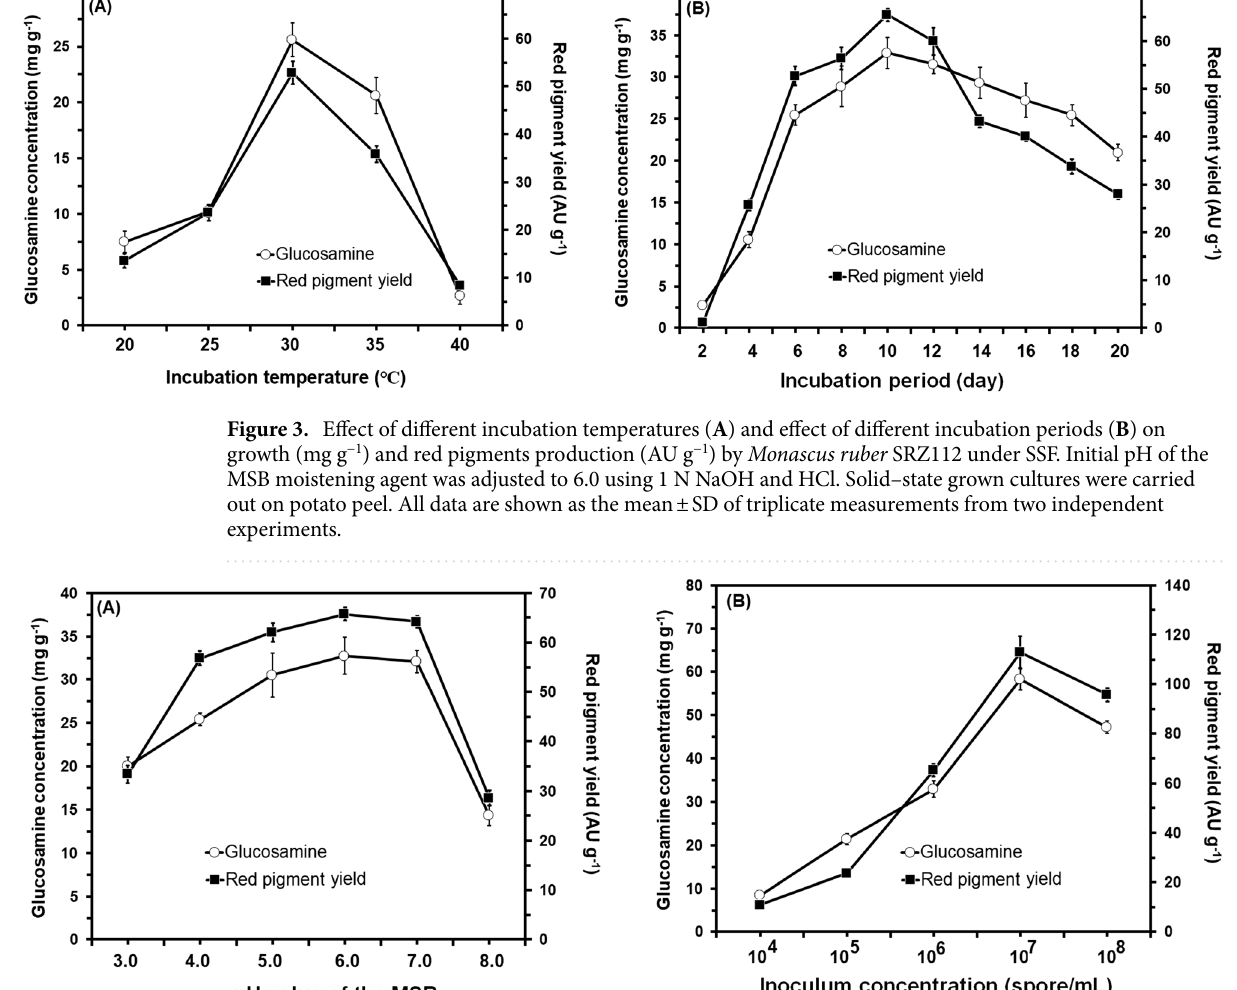
Figure 4. Effect of adjusting the pH of the MSB to different values ( A ) and effect of different inoculum concentrations ( B ) on growth (mg g −1 ) and red pigments production (AU g −1 ) by Monascus ruber SRZ112 under SSF. Initial pH of the MSB moistening agent was adjusted to varying values using 1 N NaOH and HCl. Solid– state grown cultures were carried out on potato peel at 30 °C for 10 days. All data are shown as the mean ± SD of triplicate measurements from two independent